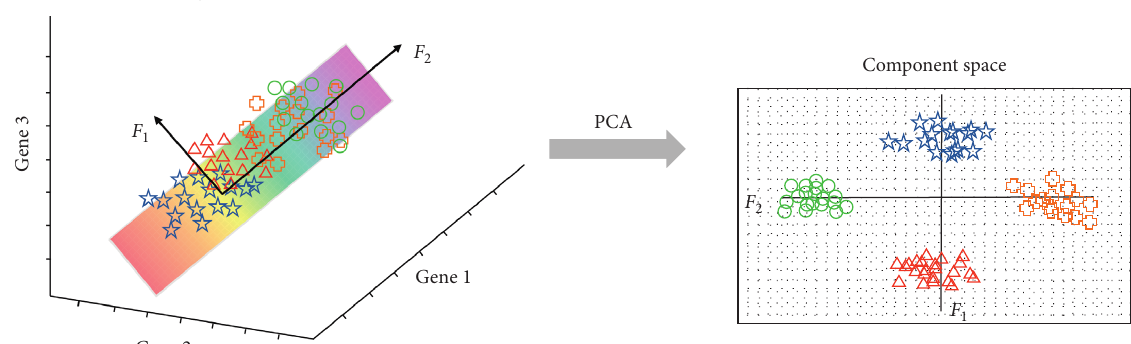
Figure 3: Schematic diagram of principal component